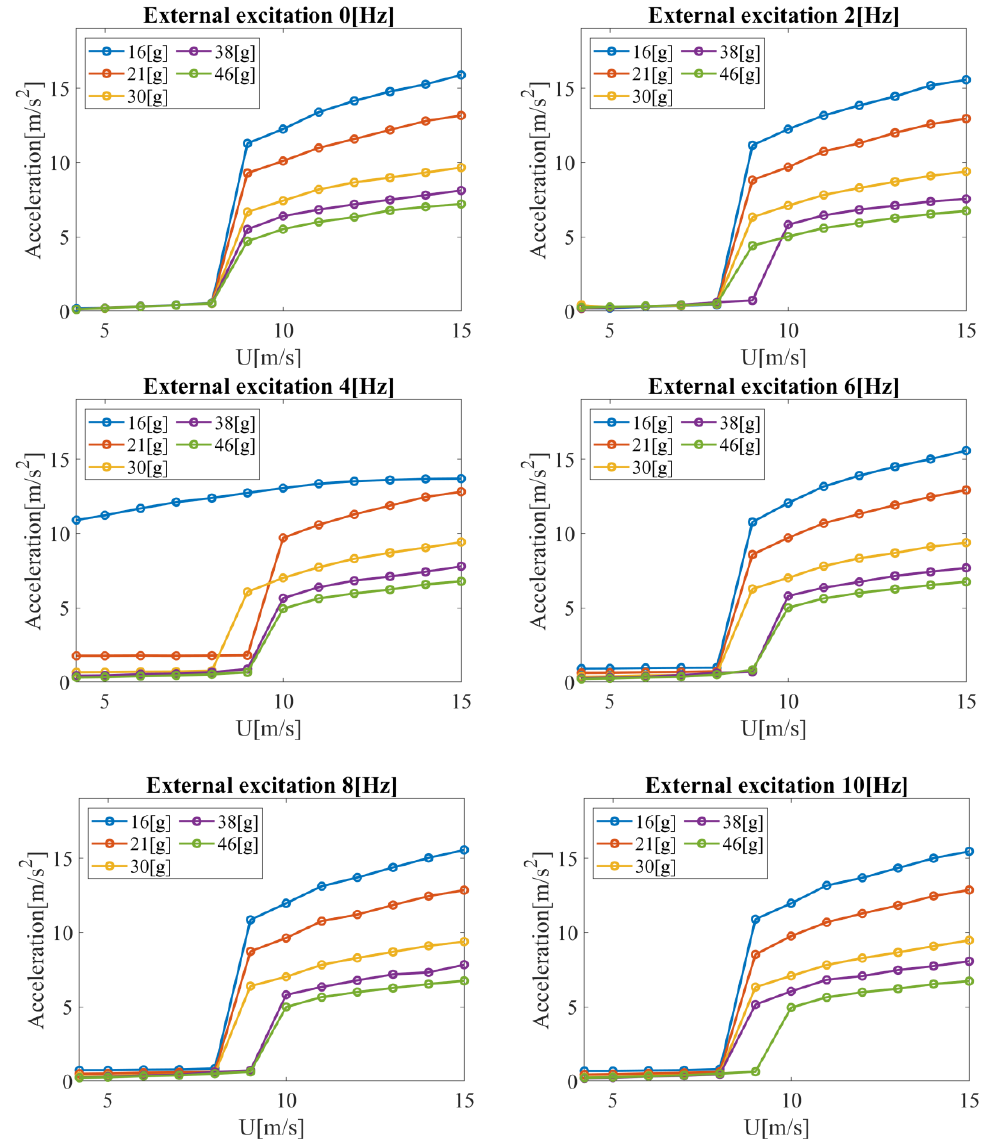
Figure 6. Acceleration of the end of the cantilever beam with the piezoelectric element as a function of air velocity for the considered bluff body masses.